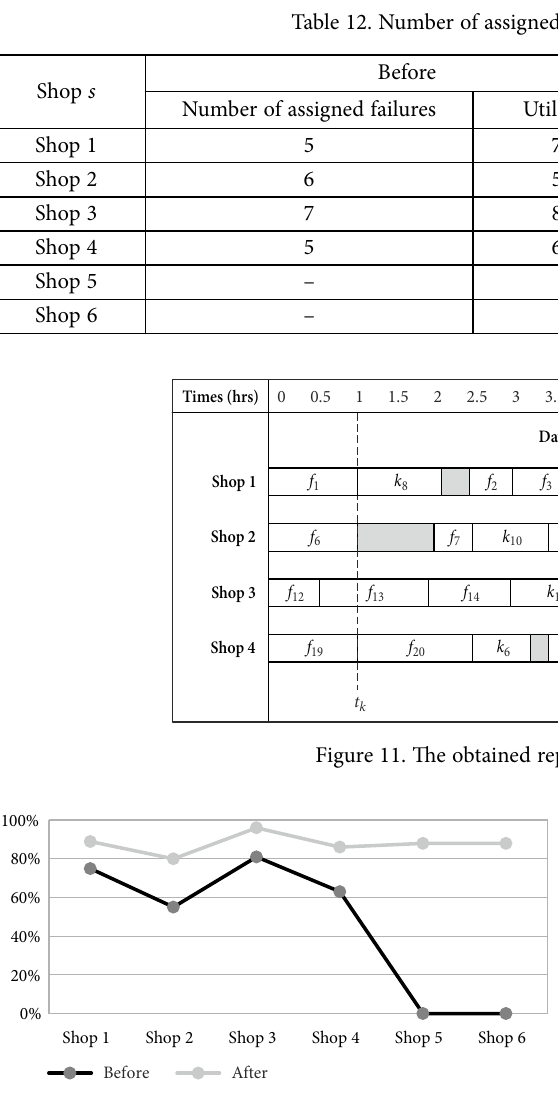
Figure 12. Utilization of the shops before and after using the